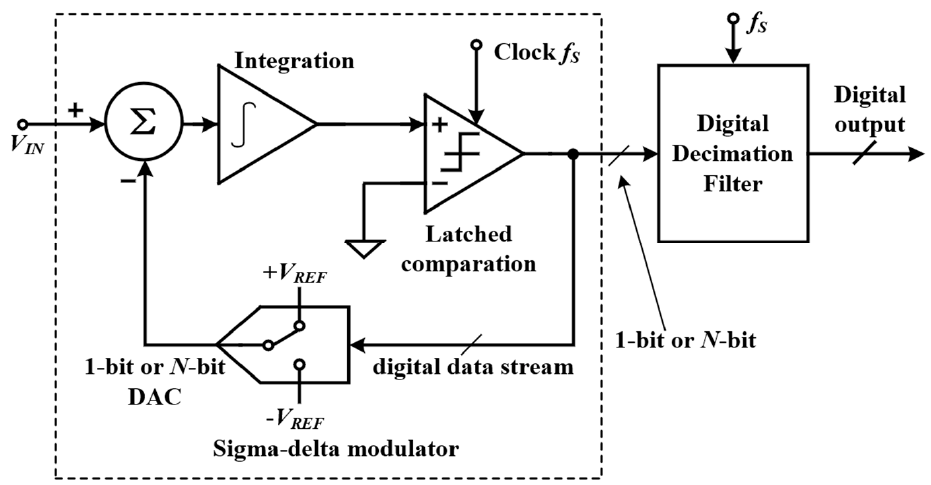
Figure 8. Basic structure diagram of Σ - ∆ ADC.